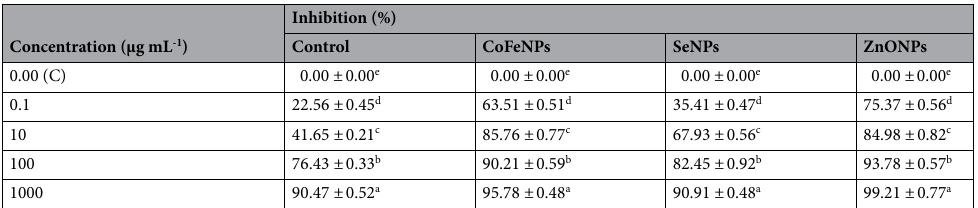
Table 5. Acetylcholinesterase inhibitiory potential of CoFeNPs, SeNPs, and ZnONPs. Galanthamine hydrobromide was used as the positive control. The calculated mean is for triplicate measurements from two independent experiments ± SD. a–e means with different superscripts in the same column are considered statistically different (LSD test, P ≤